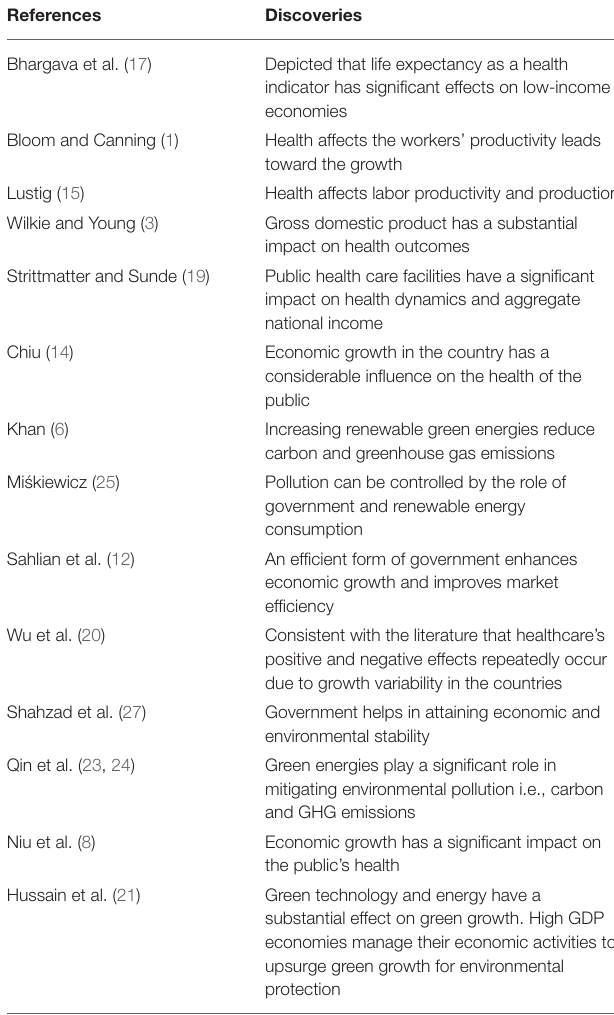
TABLE 1 | Literature summary